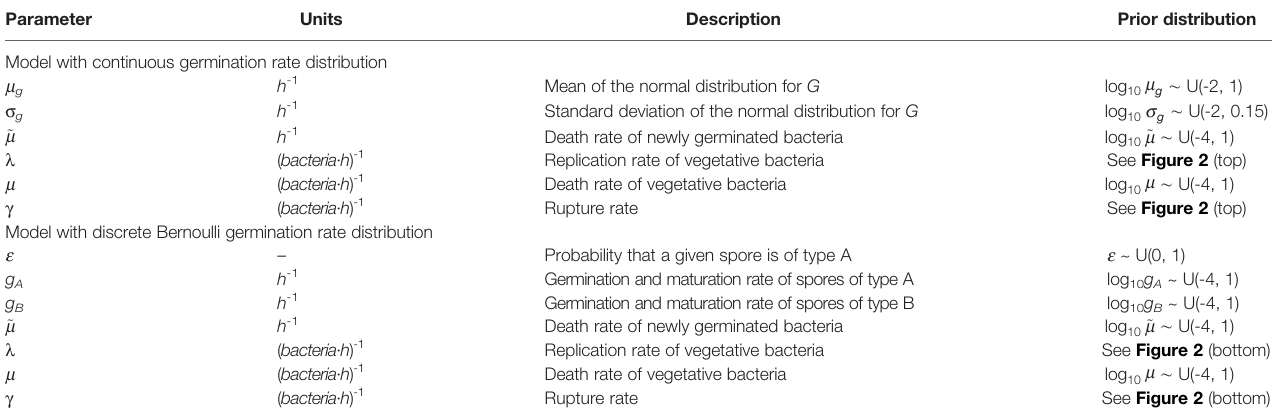
TABLE 3 | Prior distributions used in the ABC-SMC for the model with continuous heterogeneity of germination rate (top) and the model with two types of spores (bottom).